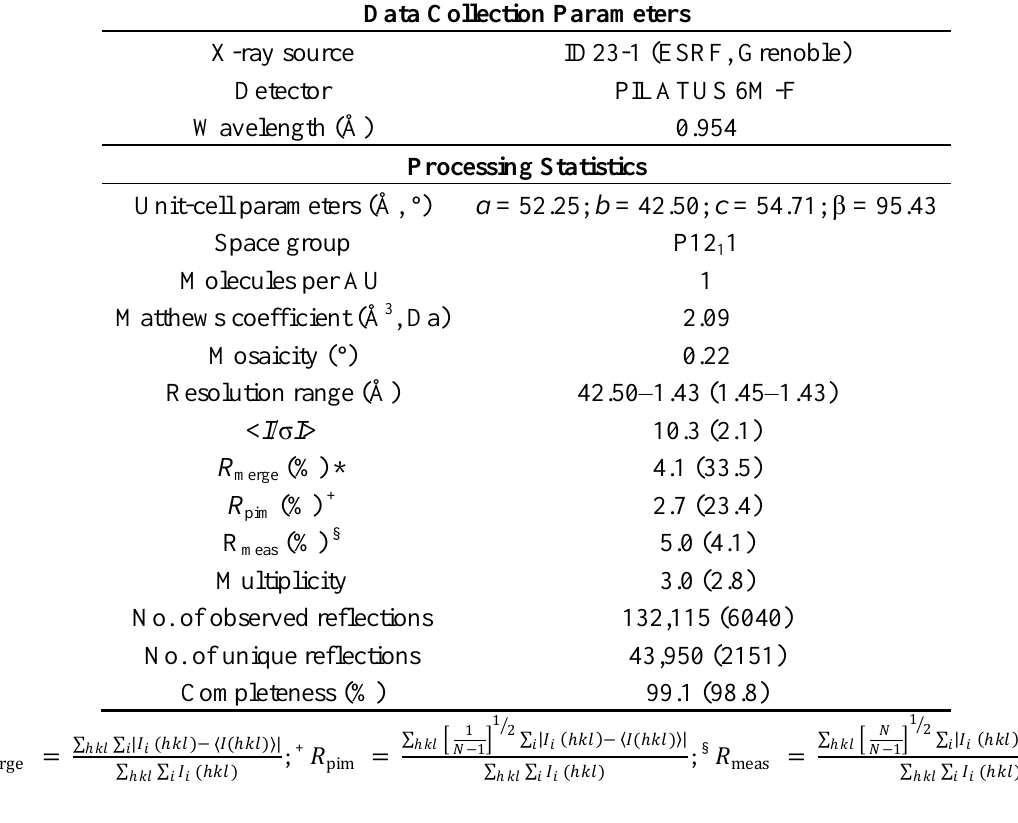
Table 2. Data collection and processing statistics for the TupA crystal. Values in parentheses correspond to the highest resolution